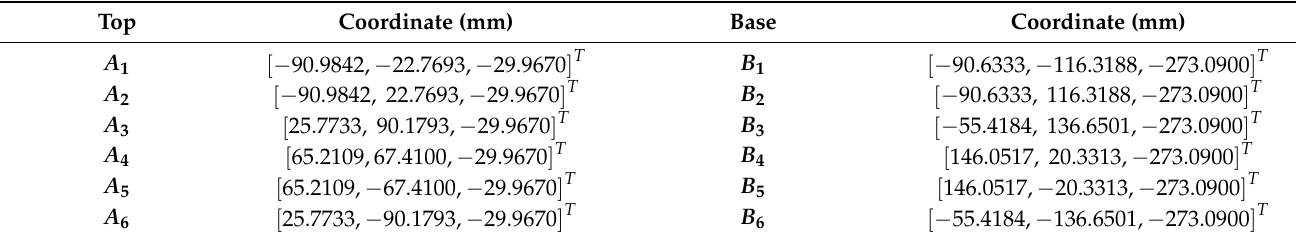
Table 9. The coordinates of the joints of the Stewart–Gough platform H-850.